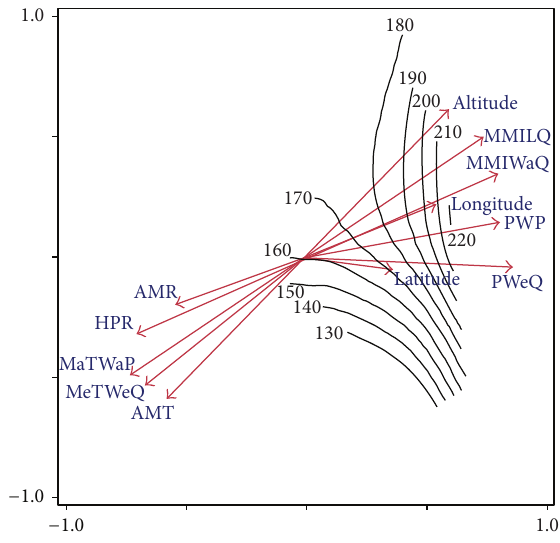
Figure 2: Generalised additive model based contour plot for AGB per plot against the 12 most significant environmental variables (minimum of 0.3% explained variance) within the CCA model. Codes given in Table 1. Axes are the first two axes of the CCA